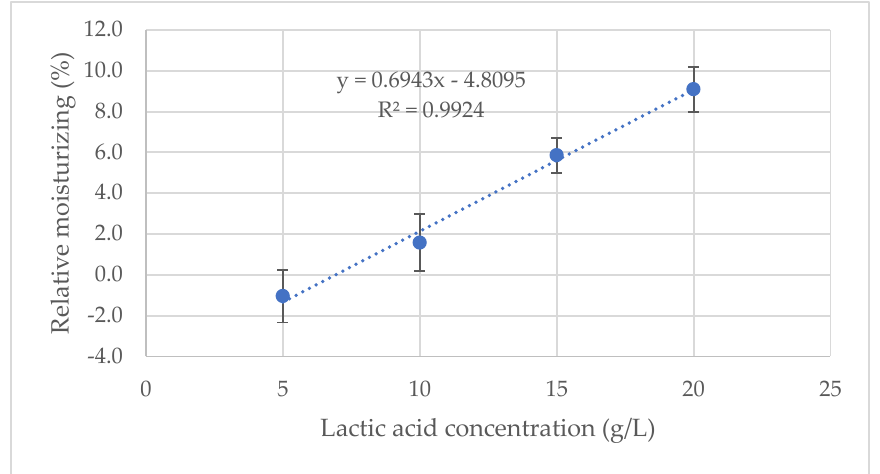
Figure 3. The skin moisturising of different lactic acid solutions. The moisturising effect calculated from the lactic acids produced can be seen in Table